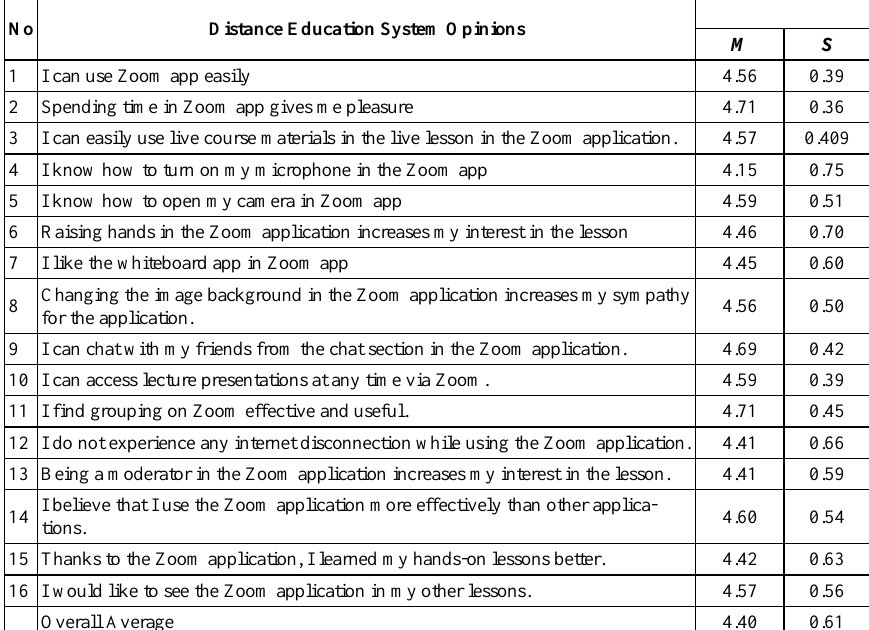
Table 6. Views of university students on the Zoom